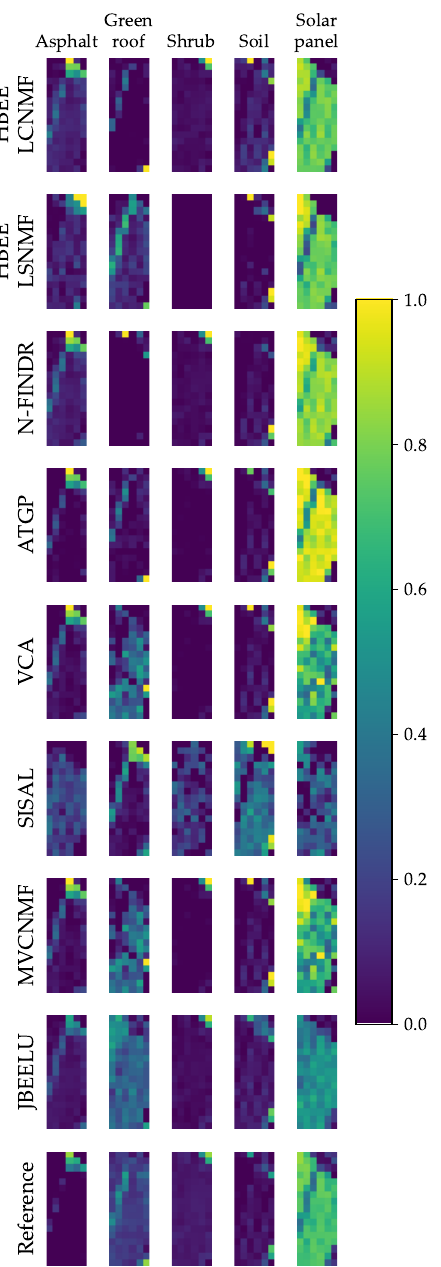
Figure 18. Estimated abundance fractions for the Mauzac data set based on the SAM estimate-reference spectrum